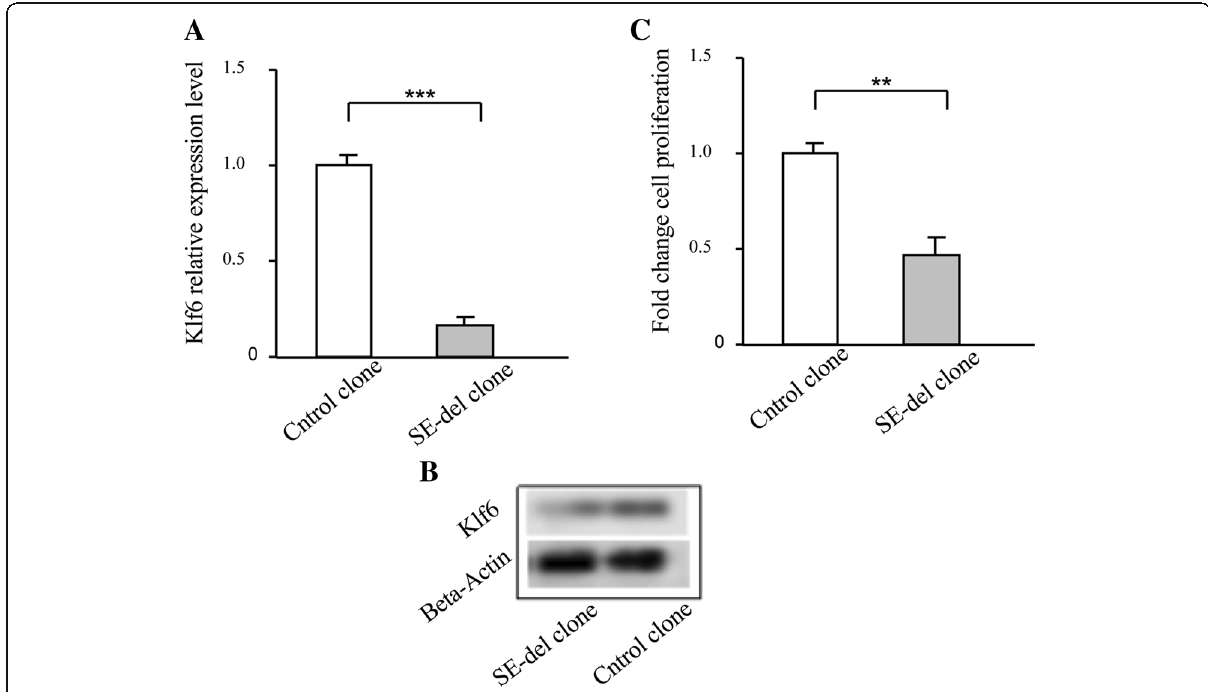
Fig. 1 Klf6 gene expression and cell proliferation assay. a Klf6 gene expression assay. The Klf6 expression level was measured by qRT-PCR. The results represent the mean of five amplifications, *** p < 0.001. b Klf6 proteins expression assay. Klf6 proteins were determined by western blot. c Cell proliferation assay. [3H] thymidine incorporation was determined at 72 h. The results represent the mean of eight experiments, ** p < 0.01